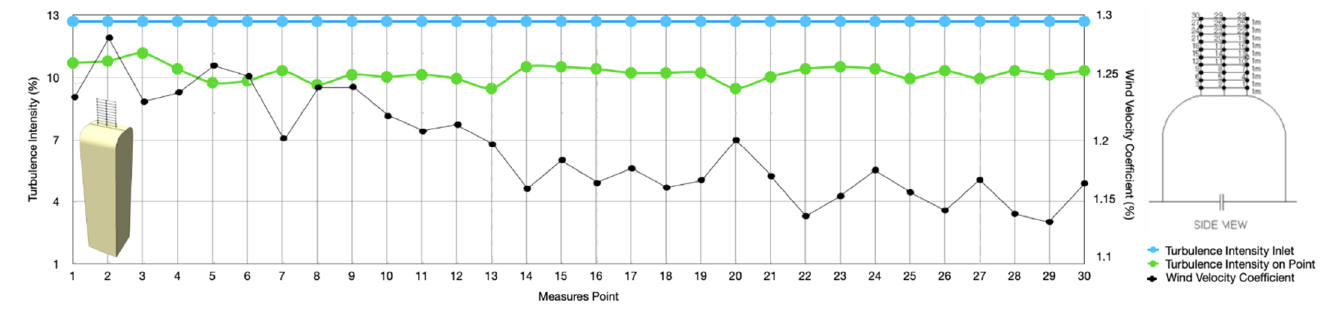
Figure 9. A wind tunnel test on building B resulted in a measurement of the velocity coefficient (VC) and turbulent intensity (TI). Wind velocity increased by 29% with rounded corners. In this design, a wind turbine was best placed at points 1 to 9 (1 m to 3 m above the roof).